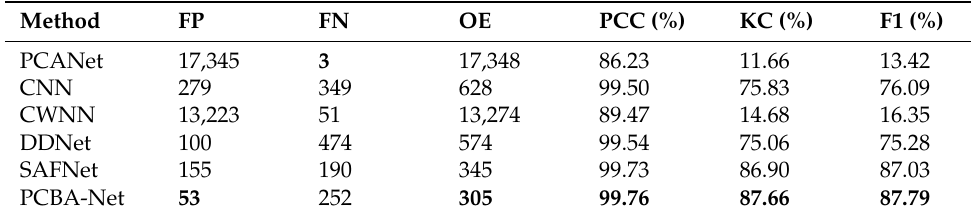
Table 7. Change detection results for Yellow River C